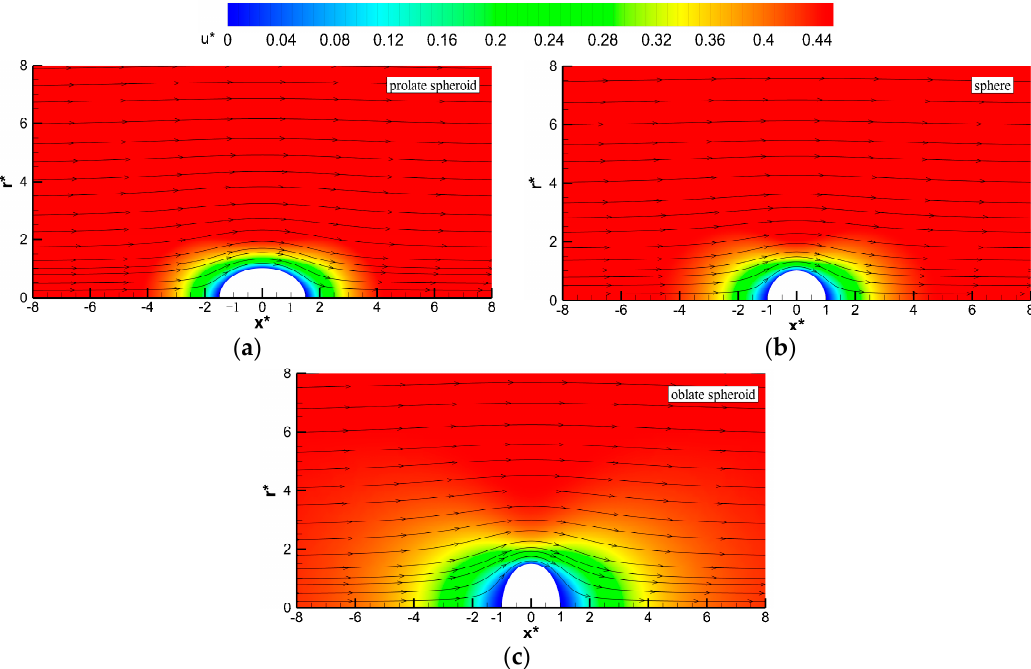
Figure 3. Distributions of the dimensionless axial velocity around the particles when κ a = 0.01 for different spheroidal particles: ( a ) prolate spheroids with b / a = 1.5 , ( b ) sphere with b / a = 1 , and ( c ) oblate spheroids with b / a = 1.5 . The solid lines with arrows denote the streamlines.